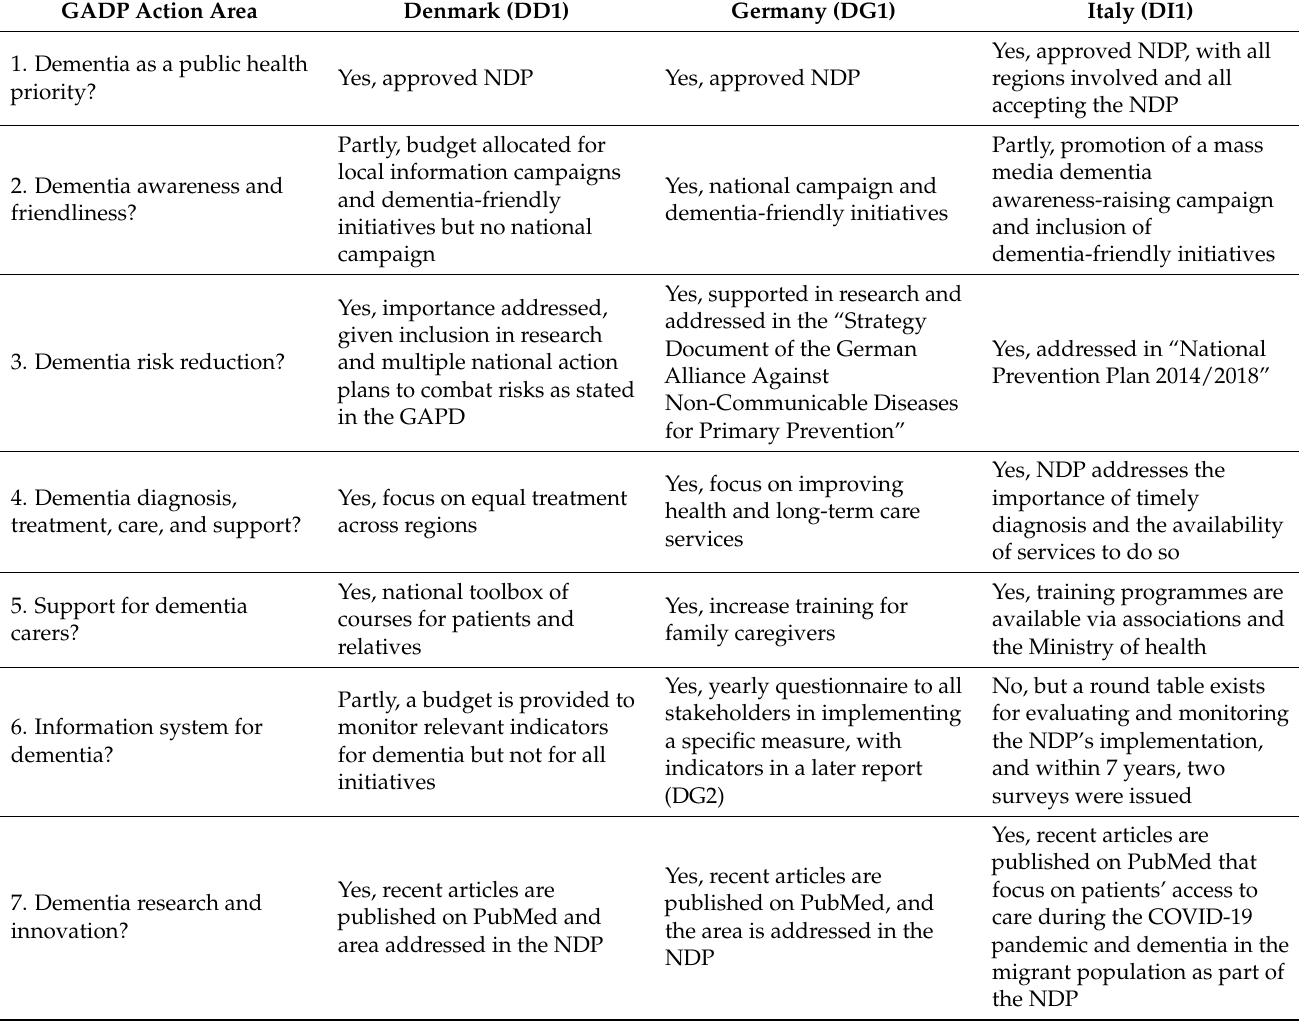
Table 3. The NDPs of Denmark, Germany, and Italy alongside the GADP action areas (WHO, 2017). GADP Action